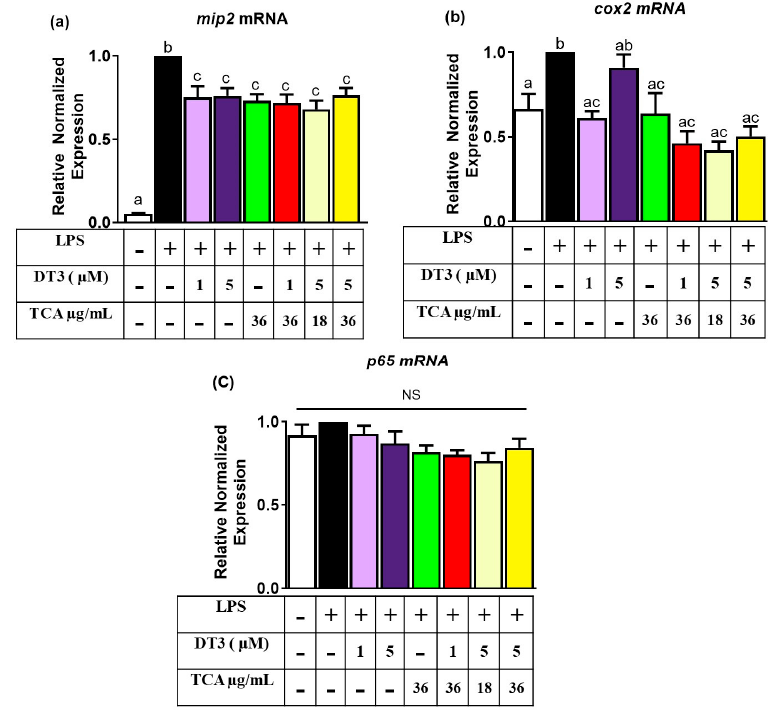
Figure 6. Delta-tocotrienol and tart cherry anthocyanins decrease pro-inflammatory downstream transcripts of NFkB: ( a ) DT3 and TCA individually and in combination significantly reduced expression of Mip2 ( b ) Cox2 ( c ) DT3 and TCA individually and in combination had no significant e ff ects on expression of p65 . Means with di ff erent letters (a, b, c) are significant. n = 6, p <